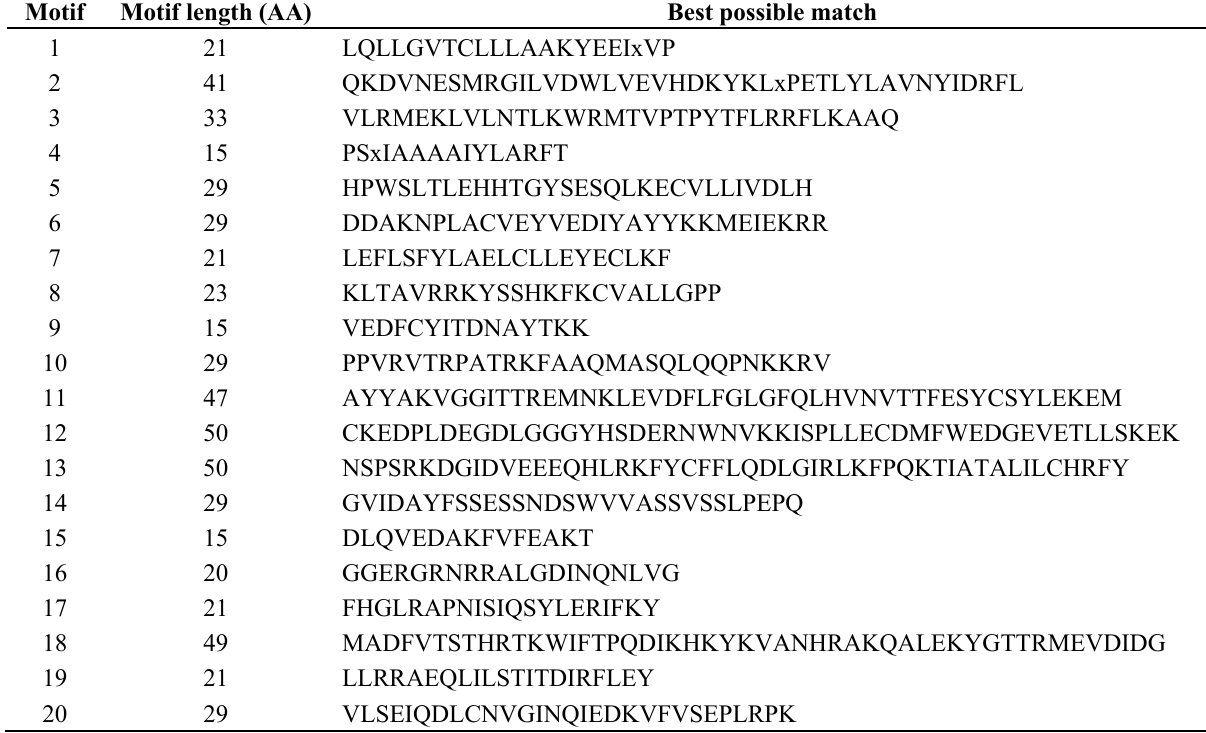
Table 2. Details of the putative